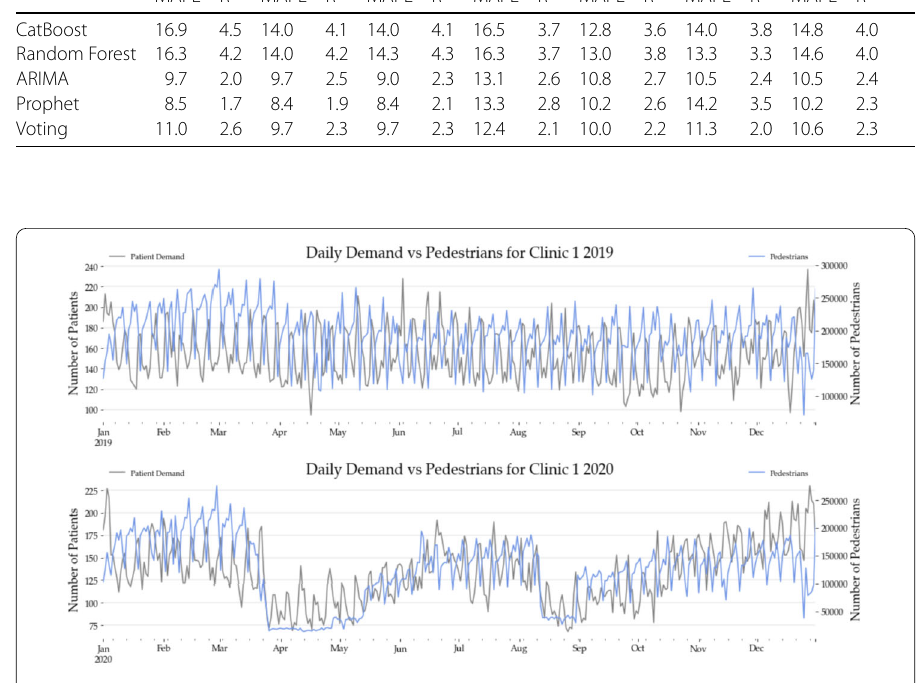
Figure 11 Pedestrian Traffic Proxy Feature for 2019 and 2020